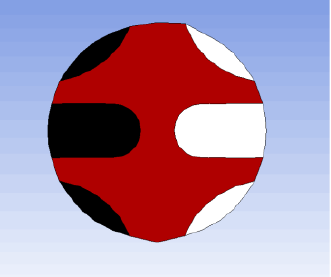
Figure 5. Simulation drawing of fiber with “fishbone“ cross -section.